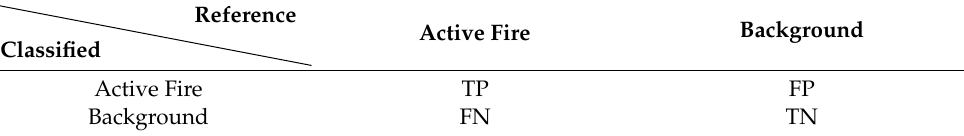
Table 2. Confusion matrix in active fire